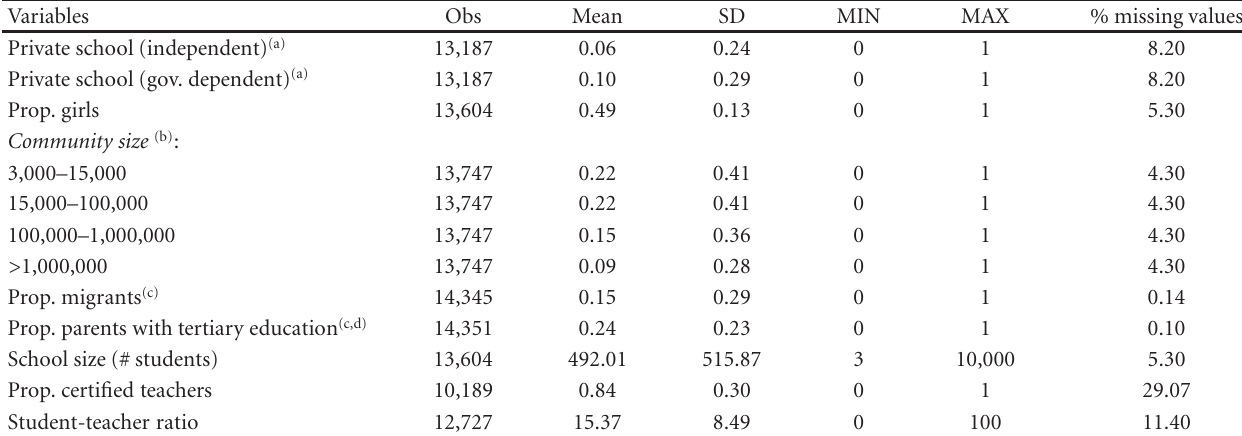
Table 2: Variables on school level ( n = 14,365, weighted by “final school weight”).